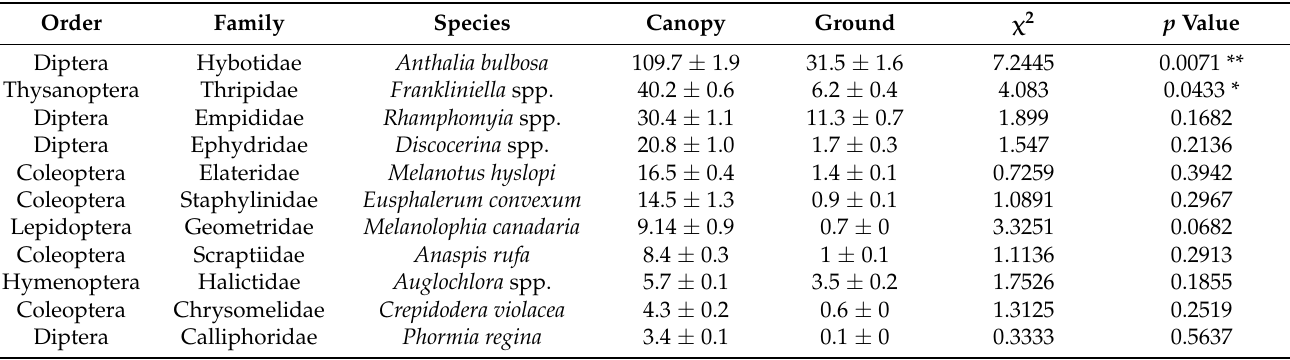
Figure 3. A total of 9533 insects were captured in the traps and Diptera was the most abundant (64.1%). Significantly more insects in Diptera, Lepidoptera and Thysanoptera were captured in the traps installed in the canopy than those on the ground and Anthalia bulbosa (Diptera: Hybotidae) was the dominant species visiting the canopy of black cherry. Different letters indicate a significant difference in trap captures at α = 0.05. Table 1. Major insect species captured per day ( ± SE) in the canopy and ground traps during the flowering period ( α = 0.05; *, p < 0.05; **, p <